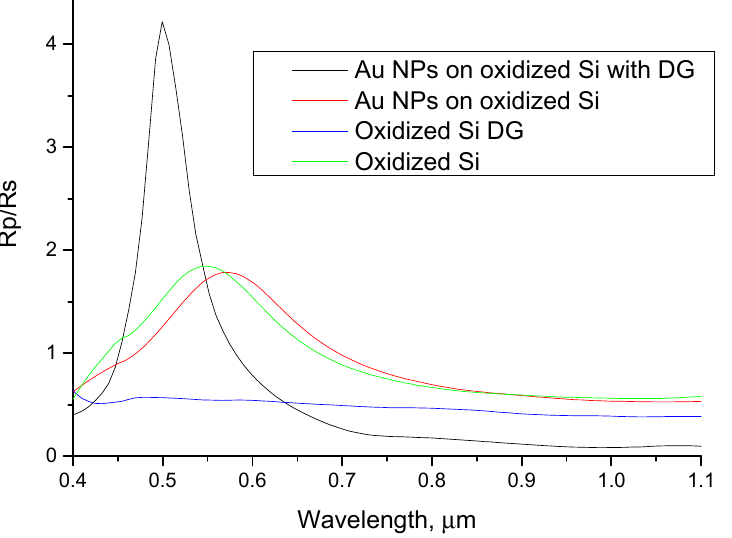
Figure 9. Comparison between samples with and without 80 nm Au NPs on oxidized flat Si and on oxidized Si with vertically aligned DG.